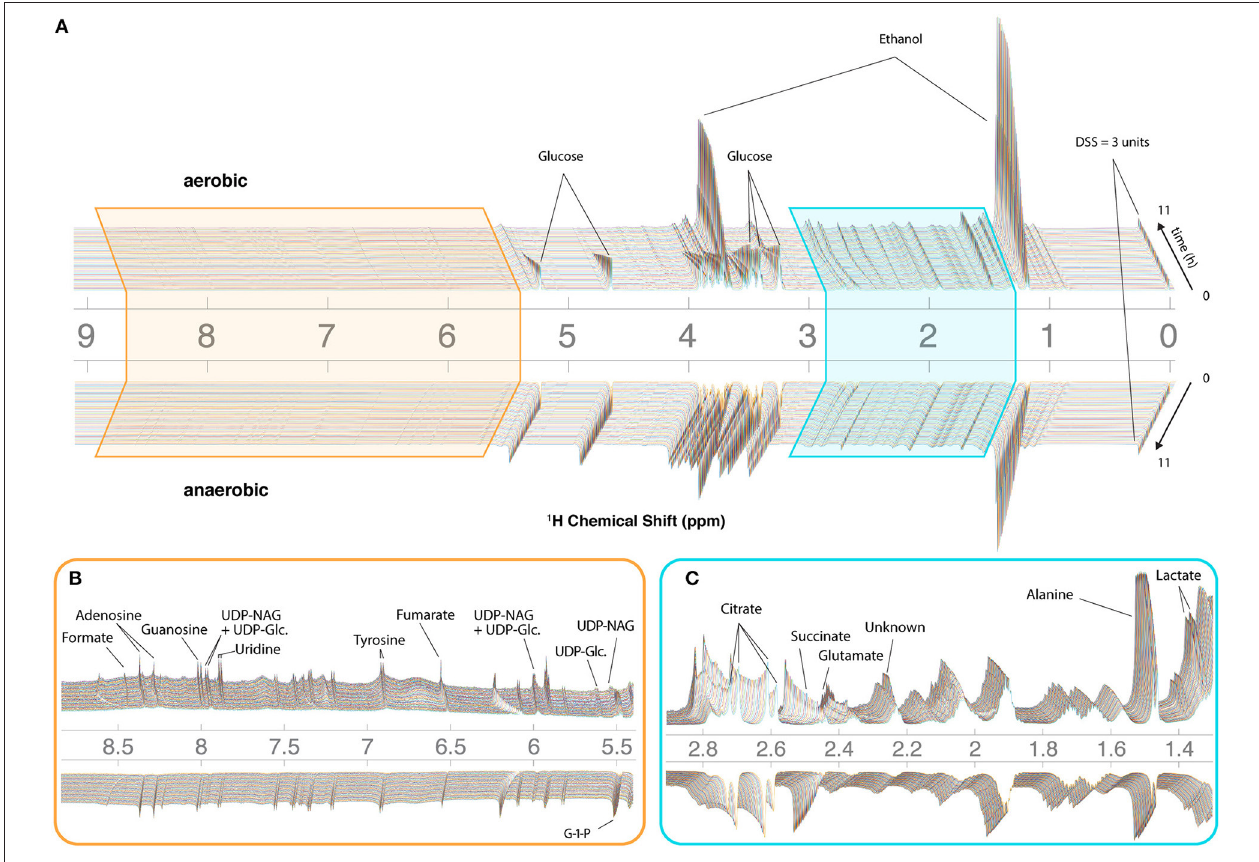
FIGURE 3 | CIVM-NMR measurements of N. crassa metabolism under aerobic and anaerobic conditions. 1 H NMR data for one aerobic replicate (top) and one anaerobic replicate (bottom) plotted interactively as a “mirror plot” for direct comparison between conditions by peak height and position at a given time. To improve the S/N, data were analyzed at 12.7min resolution. Annotations are shown for select peaks of interest for (A) the entire spectrum, and expansions of (B) the aromatic region and (C) the aliphatic region. Several peaks change position and intensity over the course of the experiments. UDP-NAG, UDP-N-Acetyl Glucosamine; UDP-Glc, UDP-Glucose; G-1-P,